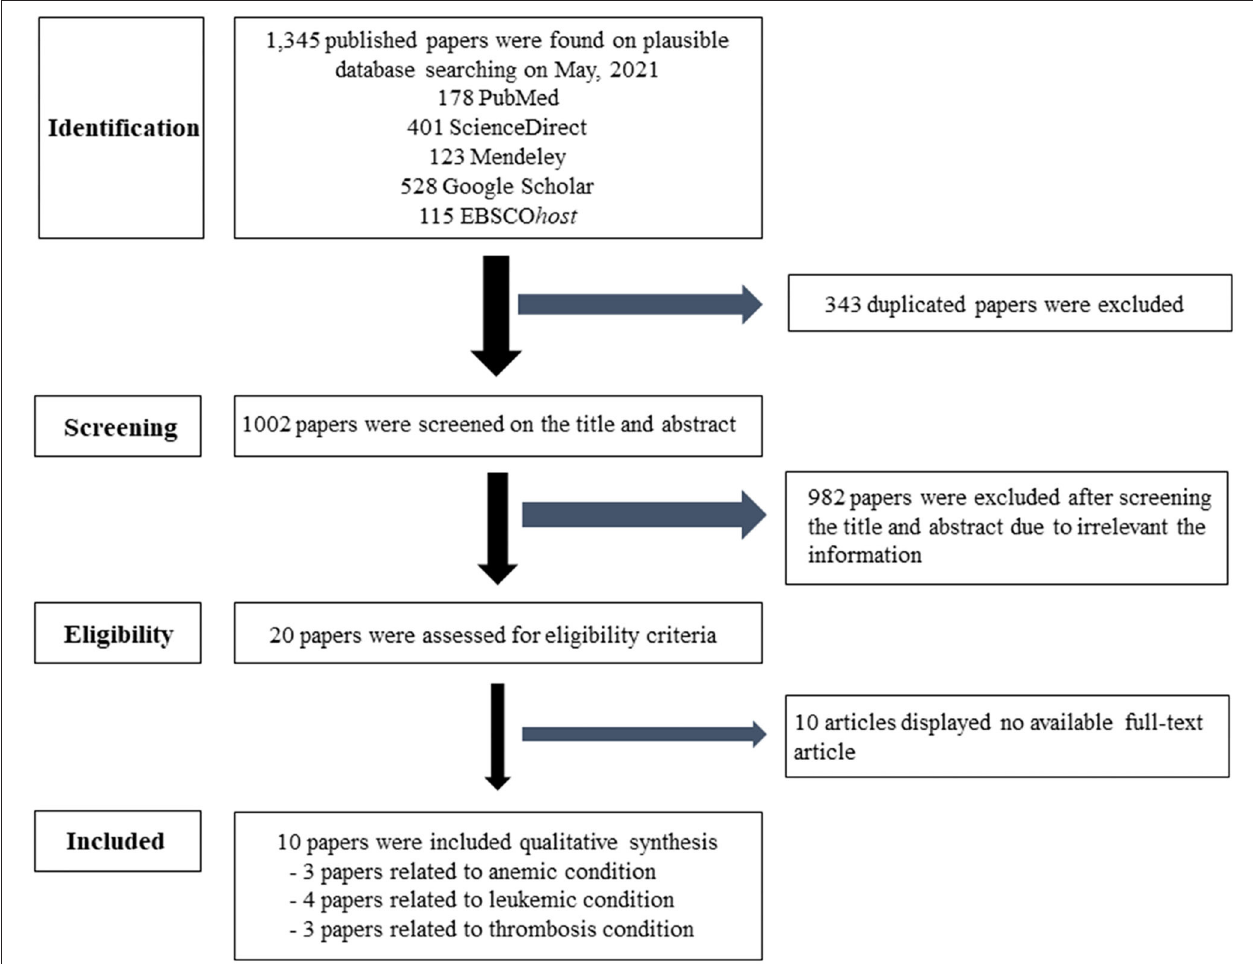
FIGURE 1 | Flow chart of the selection criteria. Ten eligible articles were included and extracted data for this